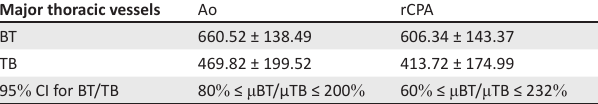
TABLE 1: The mean attenuation (HU) in the major thoracic vessels during the systemic arterial phase for the bolus tracking and test bolus techniques. Major thoracic vessels Ao